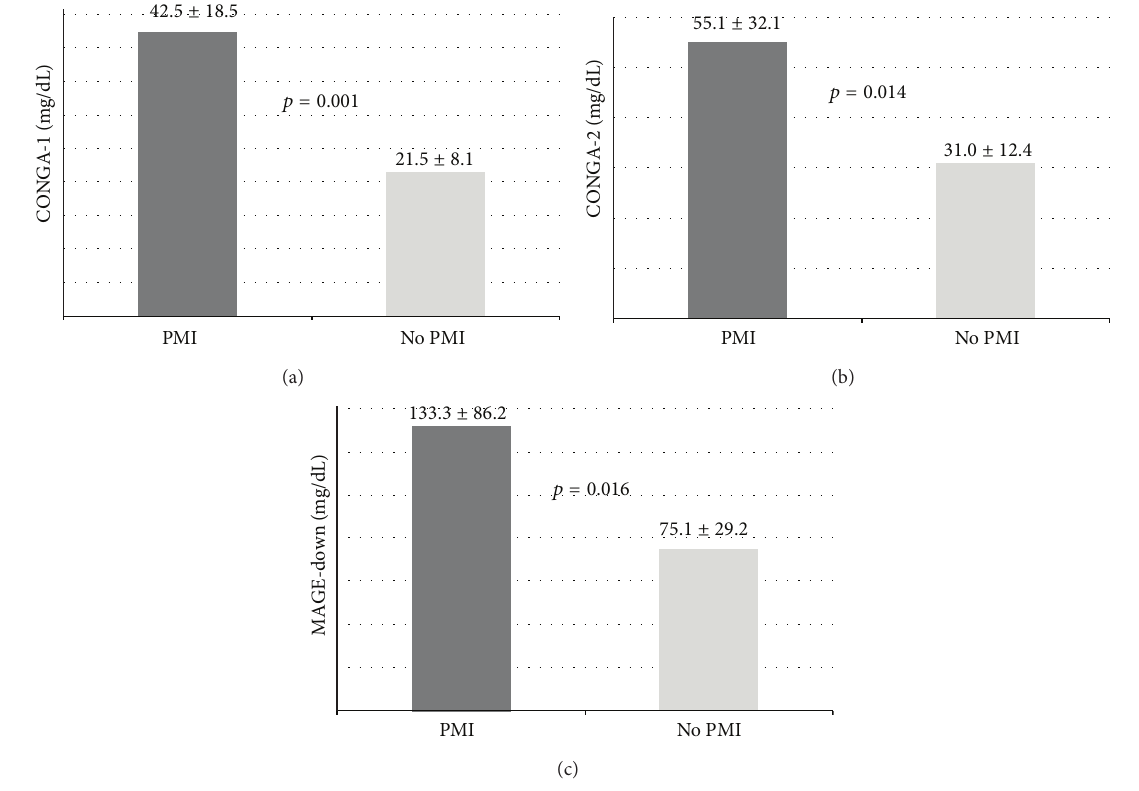
Figure 5: Glycemic variability indexes in patients with and without PMI. CONGA-1, CONGA-2, and MAGE-down values in patients with and without PMI. CONGA-1: continuous overall net glycemic action at 1 hour; CONGA-2: continuous overall net glycemic action at 2 hours;